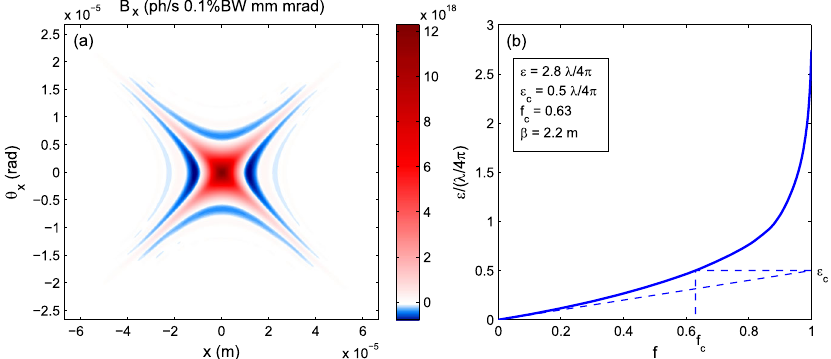
¼ 250 on resonance of the 1st harmonic at 8 keV photon energy u